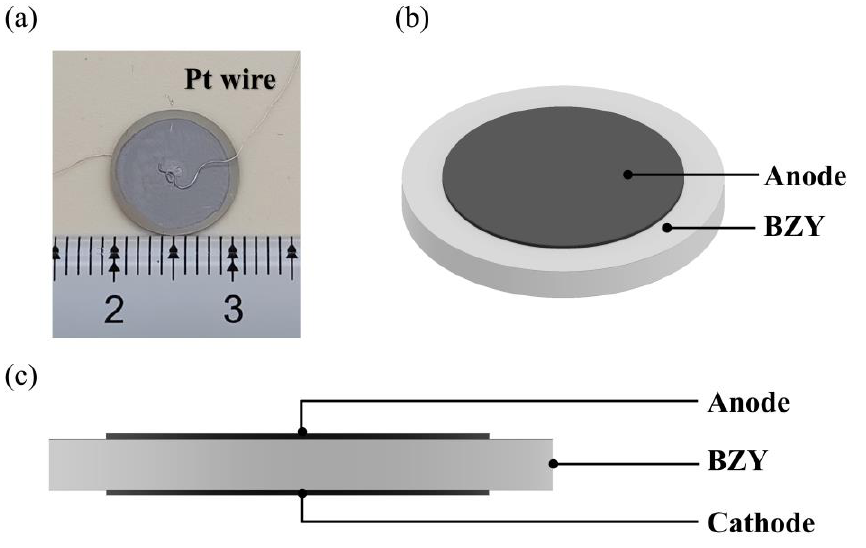
Figure 1. ( a ) Sample photograph. ( b ) The front view of the sample. ( c ) The side view of the